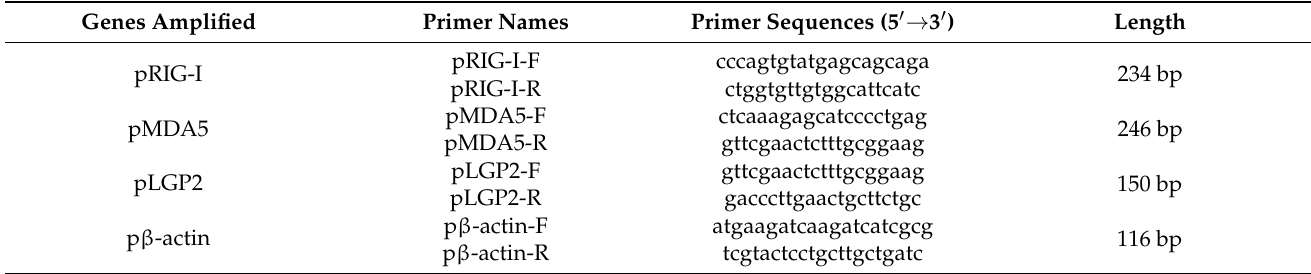
Table 2. The qPCR primer sequences for detection of porcine RLR gene